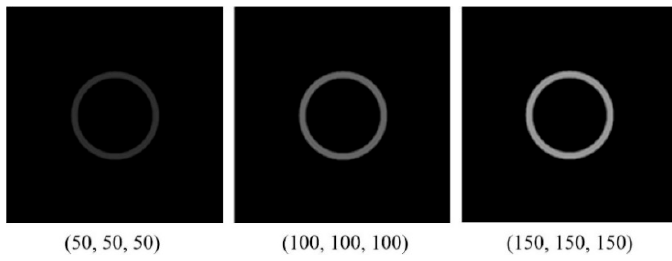
Figure 3. Different stimuli grayscale.